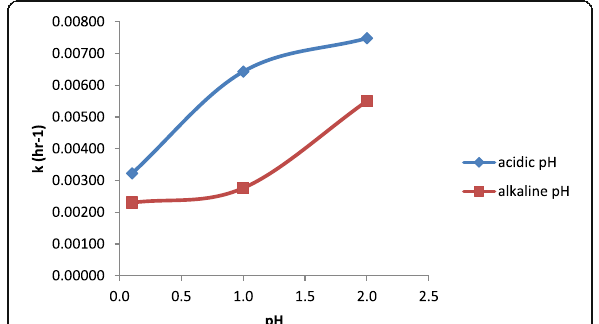
Fig. 3 Relationship between rate constant ( k ) and pH in various pH solution at 80